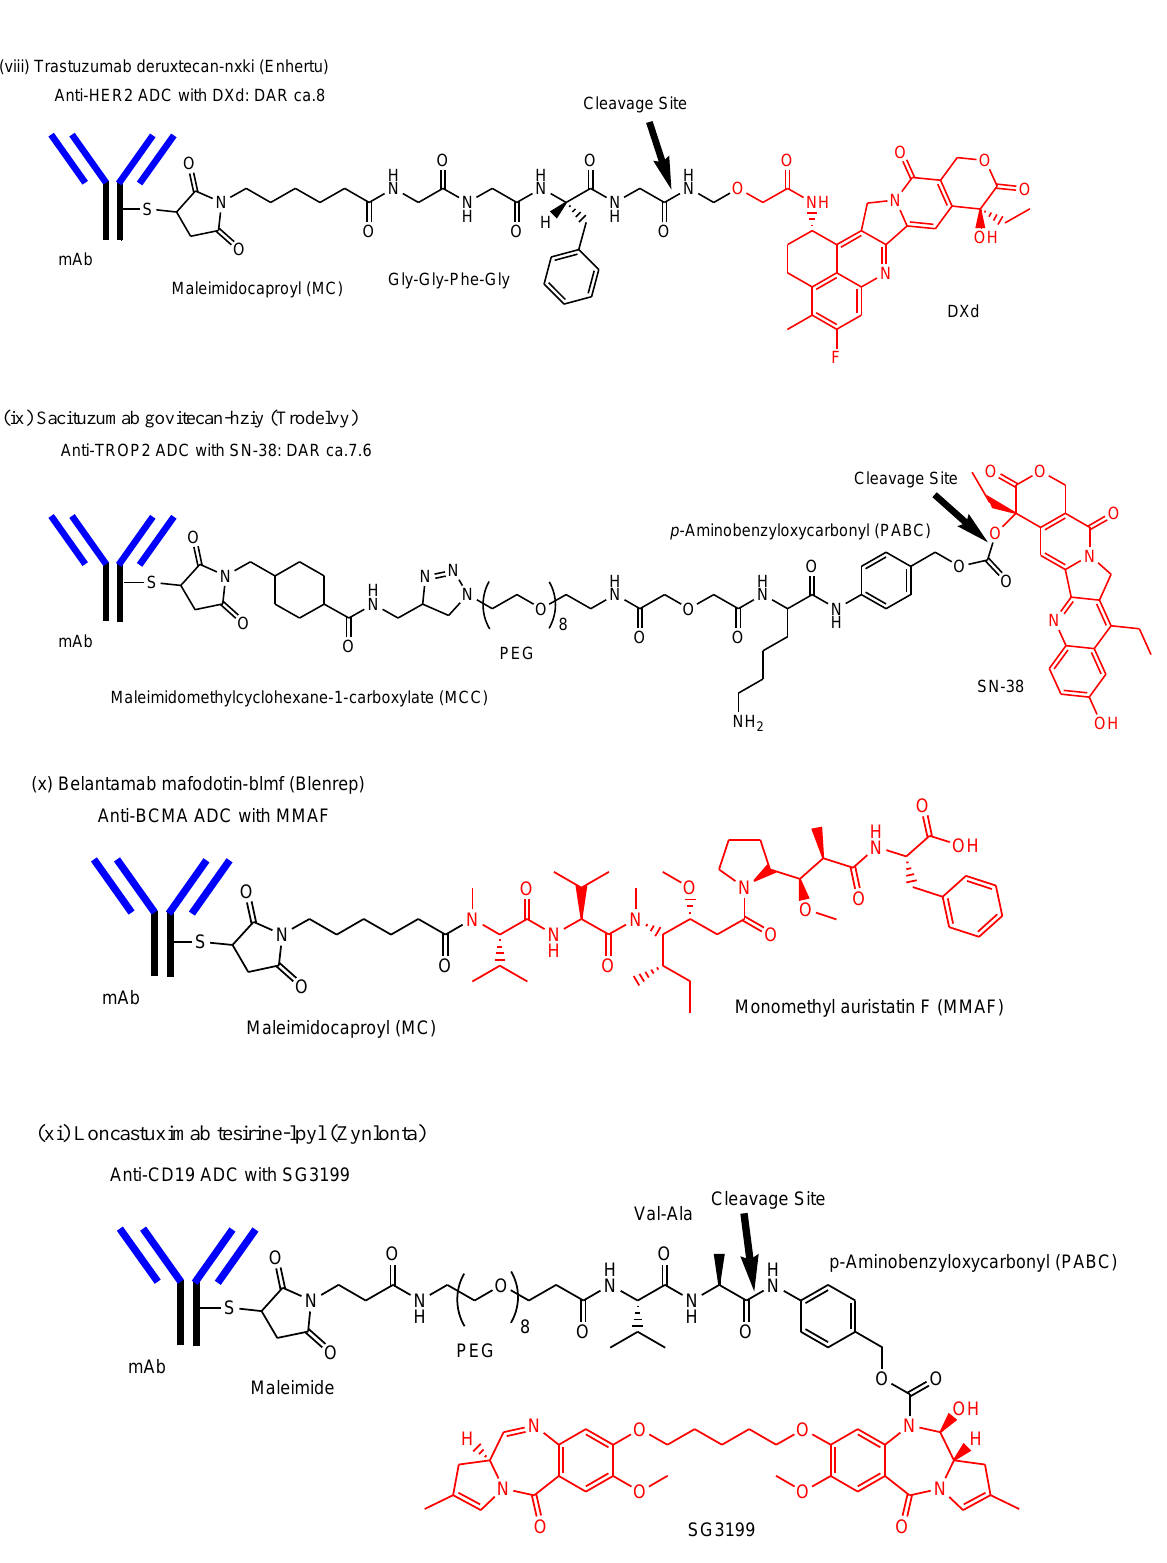
Figure 5. The structures of the FDA-approved antibody – drug conjugates (ADCs) through suitable linkers. DAR stands for drug-to-antibody ratio. (i) Gemtuzumab ozogamicin (Mylotarg ® ) and (iv) polatuzumab vedotin-piiq (Polivy ® ) have the same payload ( N -acetyl- γ -calicheamicin) and linker (acid-cleavable linker). (ii) Brentuximab vedotin (Adcetris ® ), (vi) polatuzumab vedotin-piiq (Polivy ® ), (vii) enfortumab vedotin-ejfv (Padcev ® ), and (xii) tisotumab vedotin-tftv (Tivdak ® ) have the same payload (monomethyl auristatin E (MMAE)) and linker (enzymatically cleavable linker).